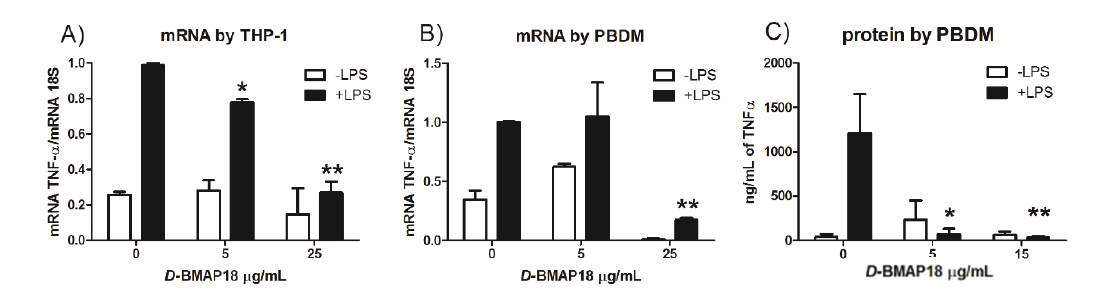
Figure 5. D -BMAP18 anti-inflammatory activity on THP-1 cells. ( A , B ) RT-qPCR expression analysis of TNF-α in LPS stimulated THP-1 cells treated with D -BMP18. After 24h treatment with 10 ng/mL LPS, and/or D -BMAP18 at 5 or 25 μg/mL, total mRNA of THP-1 ( A ) or PBDM ( B ) was isolated and gene expression analysis was performed by RT-qPCR. The expression of TNF-α mRNA was normalized to housekeeping mRNA 18S. The calibrator condition representing the cytokine expression of macrophages after stimulation with only LPS, which we considered our reference value, was 1AU. The results are the average of two independent experiments in internal duplicates ( n = 4). * p < 0.05, ** p < 0.01. Student t -test evaluated against the untreated cells. C ) ELISA assay evaluating the level of the pro-inflammatory cytokine TNF-α after a 36h treatment with LPS and D -BMAP18 at 5 and 15 μg/mL. The results are the average of two independent experiments in internal duplicates ( n